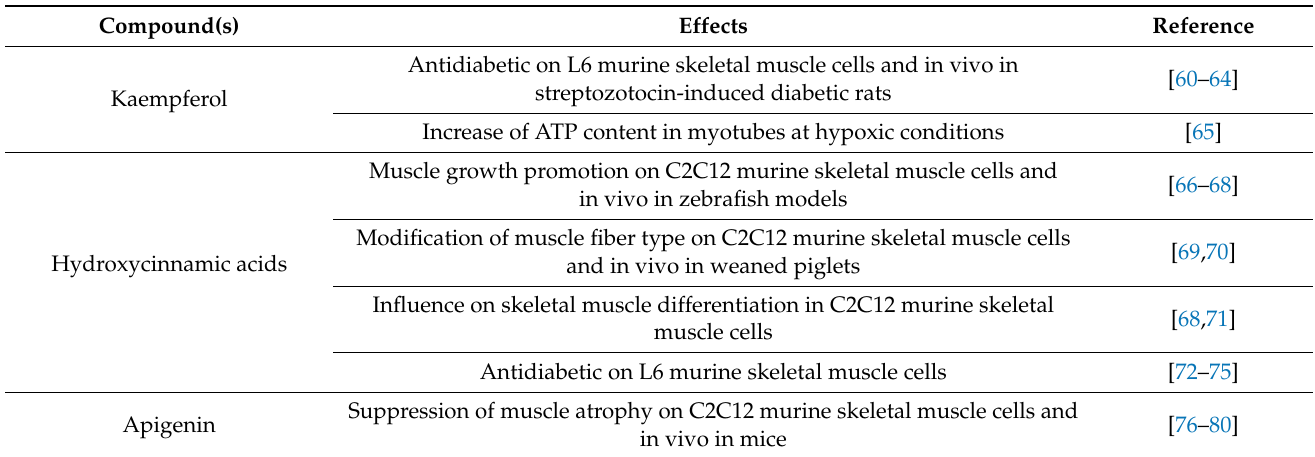
Table 2. Summary of main laurel leaf polyphenols’ effects on skeletal